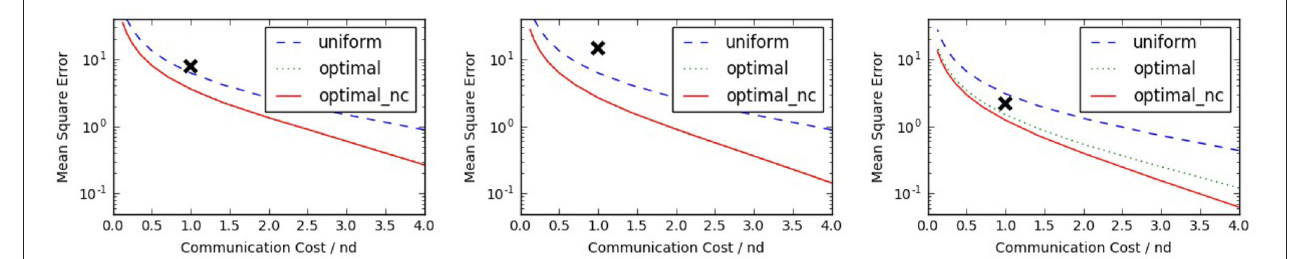
FIGURE 1 | Trade-off curves between communication cost and estimation error (MSE) for four protocols. The plots correspond to vectors X i drawn in an i.i.d. fashion from Gaussian, Laplace, and χ 2 distributions, from left to right. The black cross marks the performance of binary quantization (Example